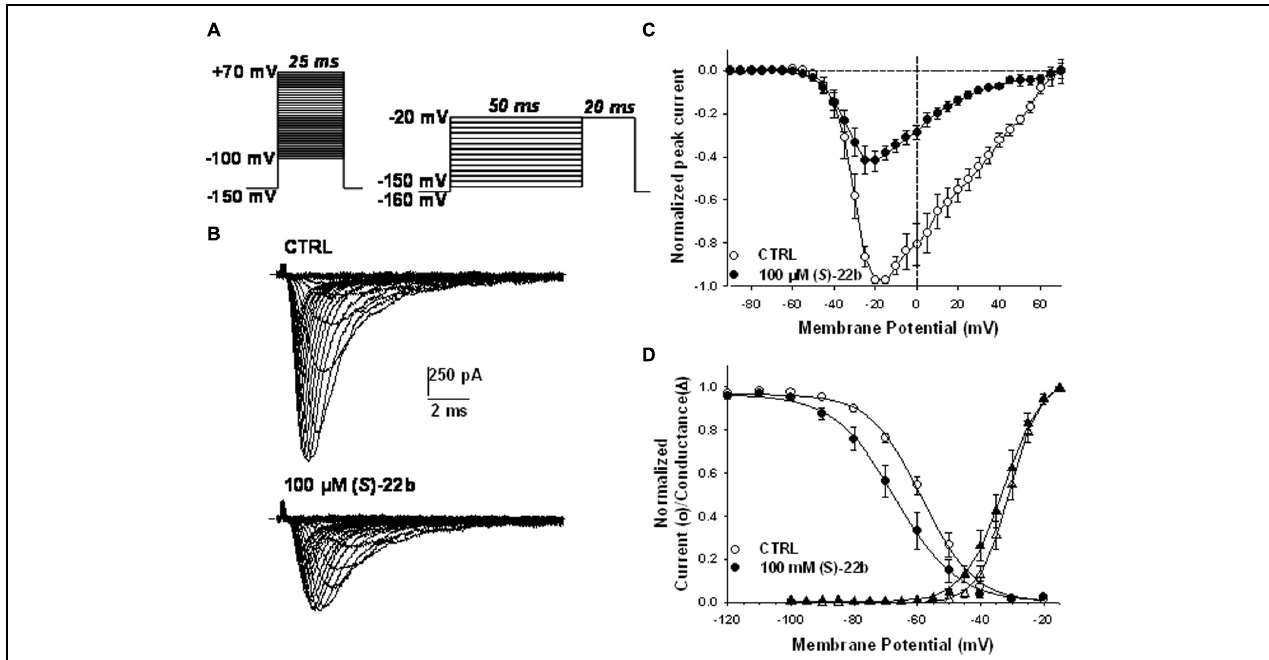
FIGURE 4 | Effects of 100 µ M ( S )-22b on the voltage dependence of hNav1.7 channels. (A) Left protocol, to obtain the current–voltage (I–V) and activation relationships, the membrane was held at –150 mV and depolarized by successive 25 ms-long voltage steps ranging from –100 to + 70 mV applied in 5-mV increments every 10 s. Right protocol, to obtain the voltage dependence of steady state availability (fast inactivation), the membrane was held at –160 mV, and conditioning 50 ms-long voltage steps were applied from –120 to –20 mV in 10-mV increments, before to apply a 20 ms-long test pulse at –20 mV. (B) Families of sodium currents recorded in a representative cell using the left protocol shown in (A) , in control conditions (CTRL) and at steady state during the application of 100 µ M ( S )-22b. (C) Averaged I–V relationships obtained using the left protocol shown in (A) .